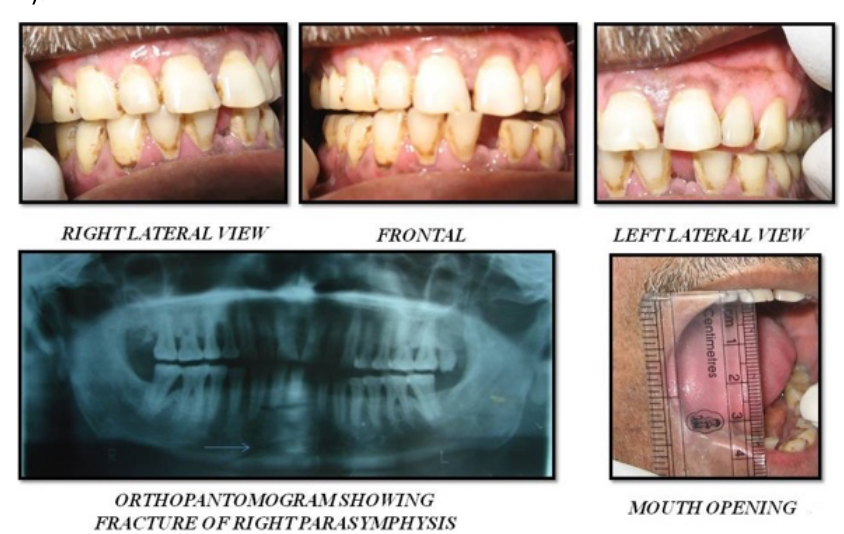
Figure 1. Case 1 – Preoperative view showing right parasymphysis fracture